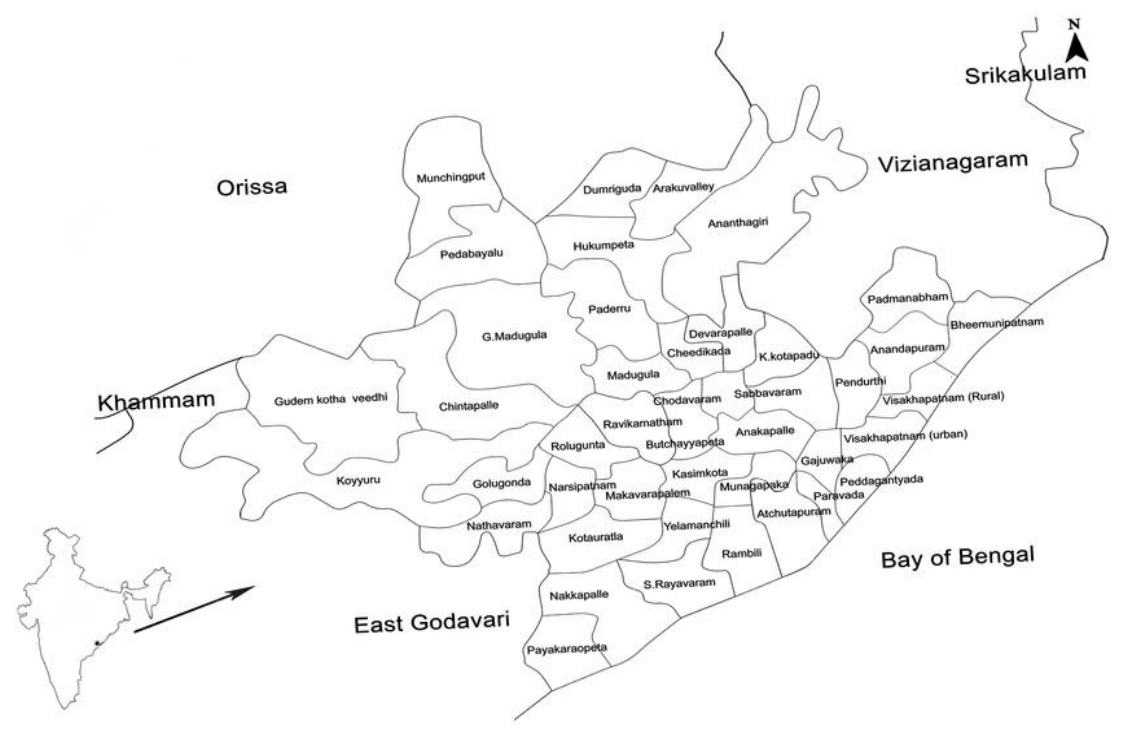
Figure 3. Locations of climatic stations in the study area.